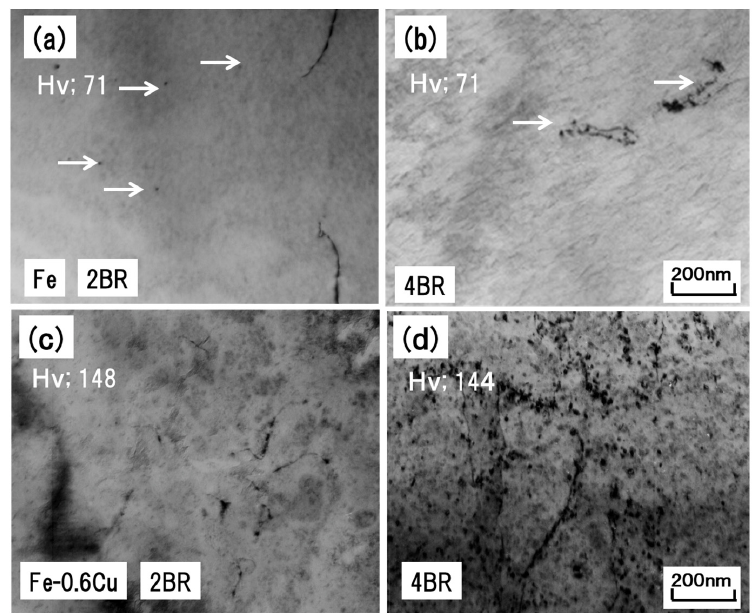
Figure 2. Microstructure of pure Fe and Fe-0.6wt%Cu alloy irradiated at 290 °C: ( a , c ) 06M-2BR, ( b , d ) 06M-4BR. Dislocation loops were shown by arrows.